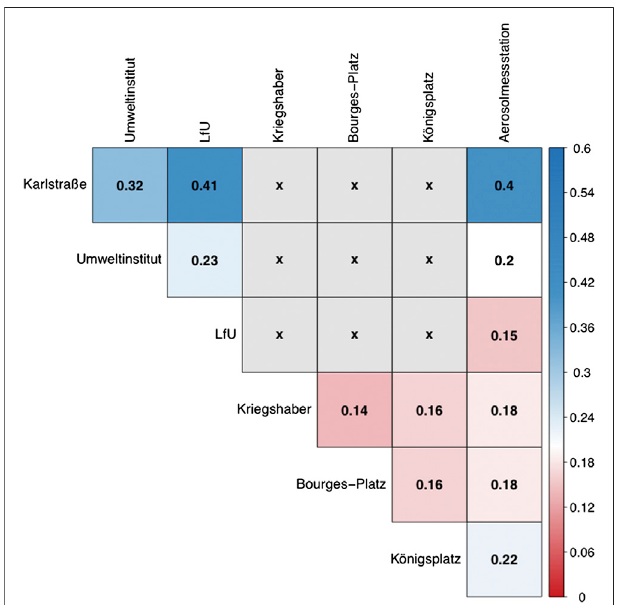
FIGURE 6 | Coef fi cients of divergence between the hourly UFP number concentrations of all measurement